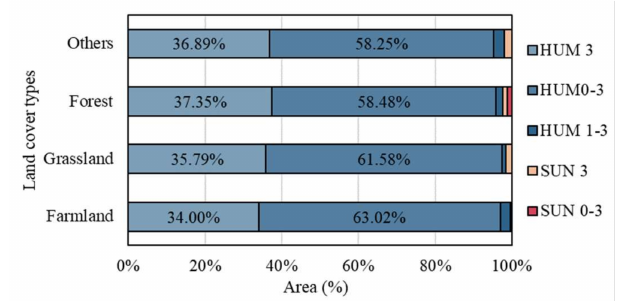
Figure 8. Time lags for different land cover types.